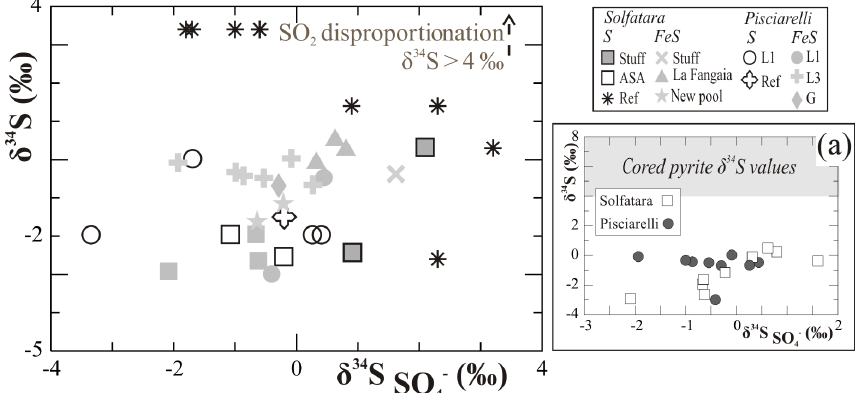
Figure 6. Distribution of δ 34 S values among coexisting sulfates, sulfides and native sulfur (S in legend), organized on the basis of the sampling sites. Note: (i) the nearly similar values of sulfates and sulfides at Solfatara coherent with supergene setting; (ii) the higher δ 34 S values in sulfides at Pisciarelli indicating a different, likely not biogenic (in that case sulfate must be heavy) process or stage; (iii) likely positive correlations between Solfatara sulfides and sulfates (panel a ); “Ref” indicates literature data.